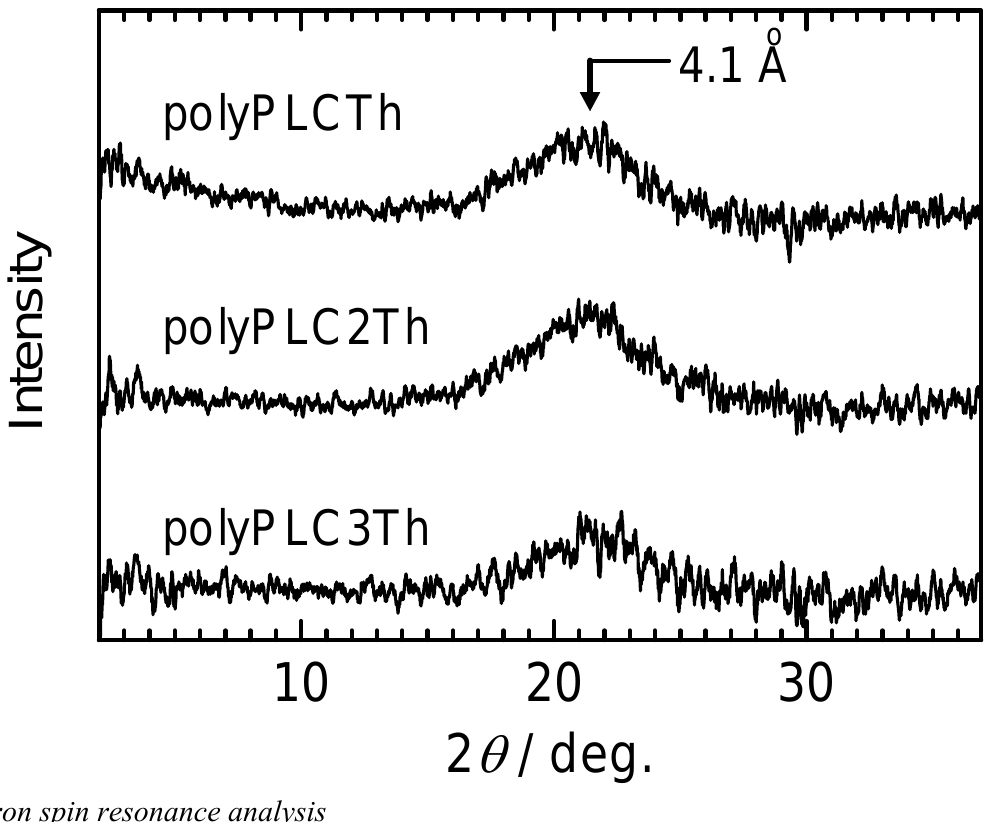
Figure 10. X-ray diffraction (XRD) pattern of the polymers at room temperature. The samples were obtained after cooling from the isotropic